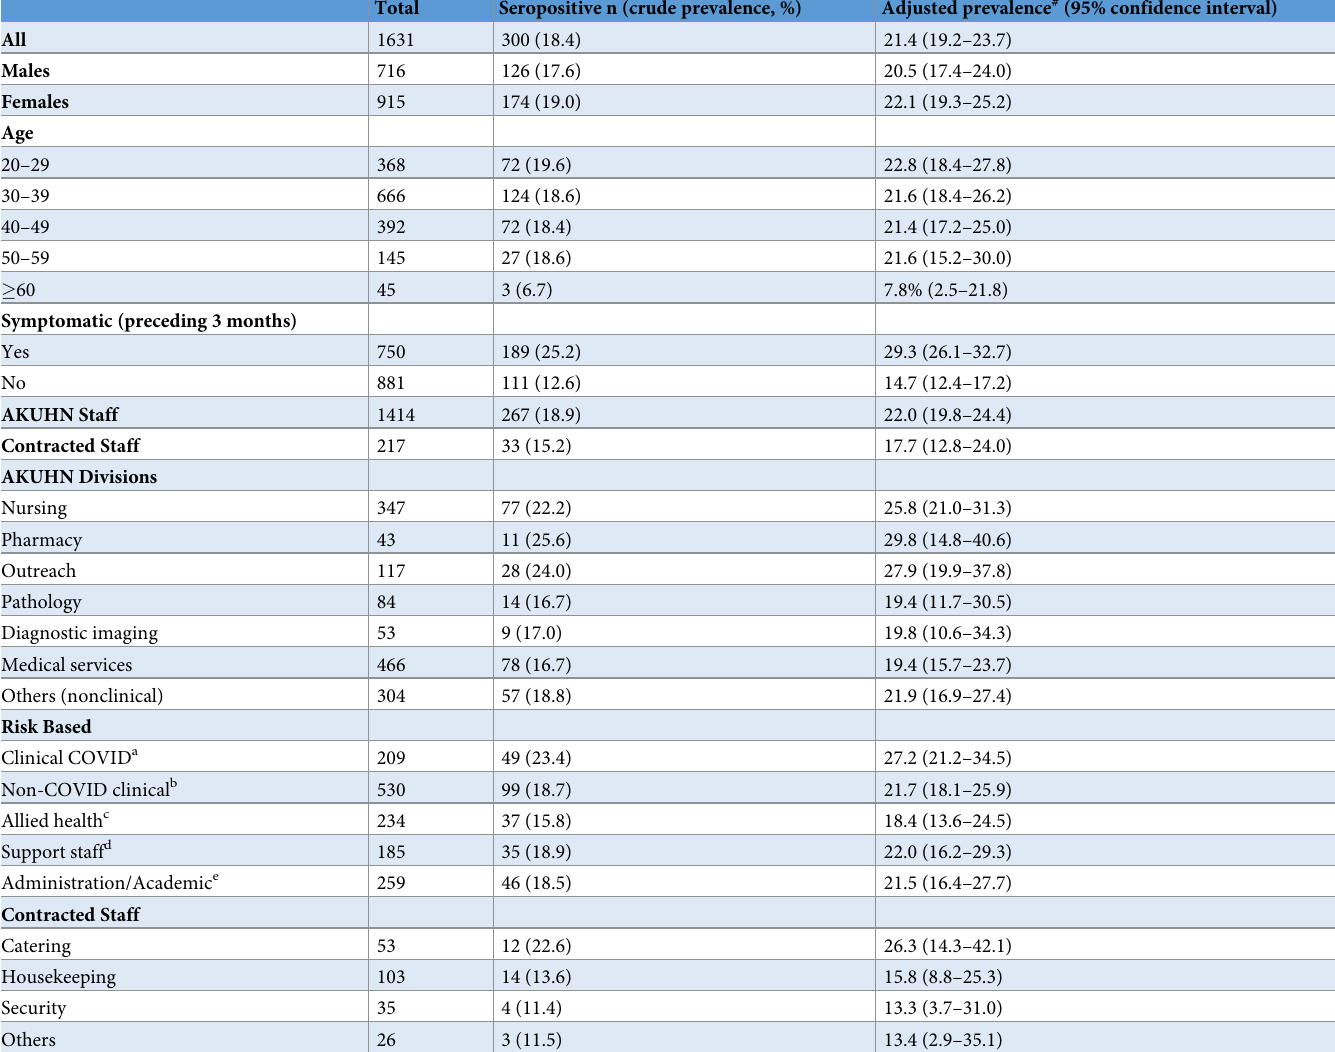
Table 2. SARS-CoV-2 anti-nucleocapsid IgG antibody prevalence by participant characteristics.